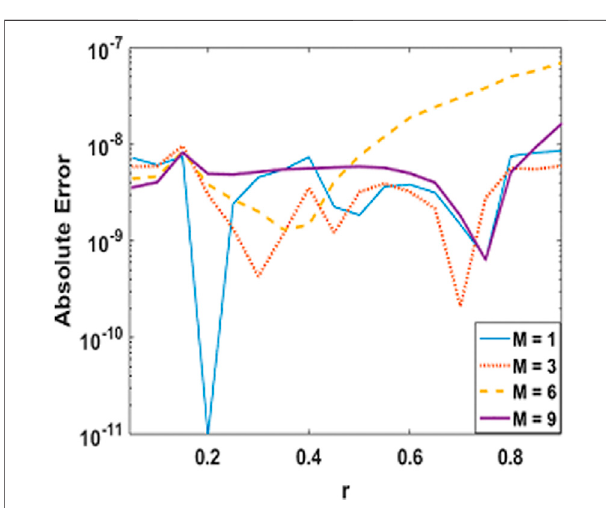
FIGURE 4 | Error in H3(r) for magnetic parameter.